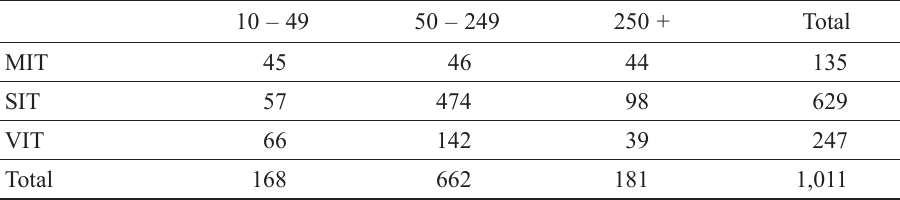
Table 5. Structure of the observed sample,